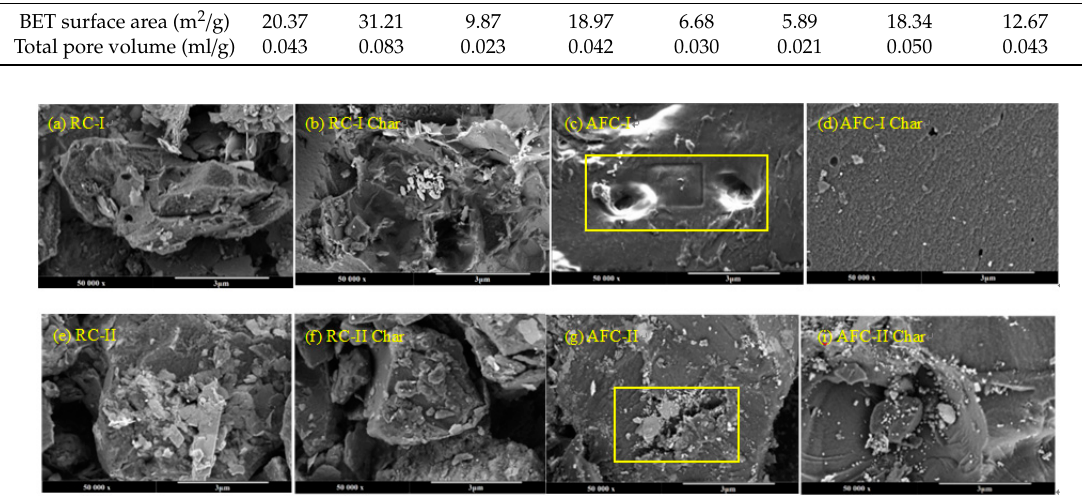
Figure 3. SEM of RCs, AFCs and their Chars ( a – d : coal I, e – i : coal II).